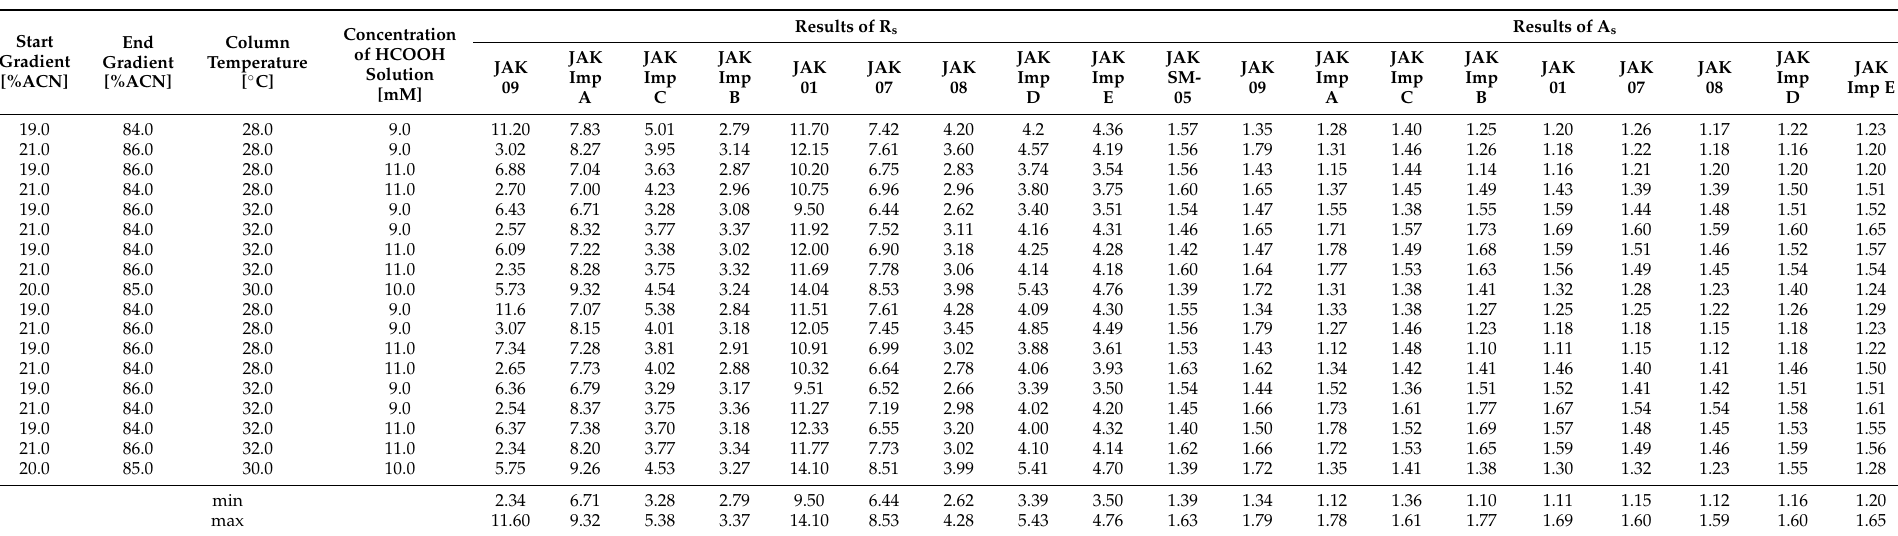
Table 5. Plan of the design and raw data of robustness